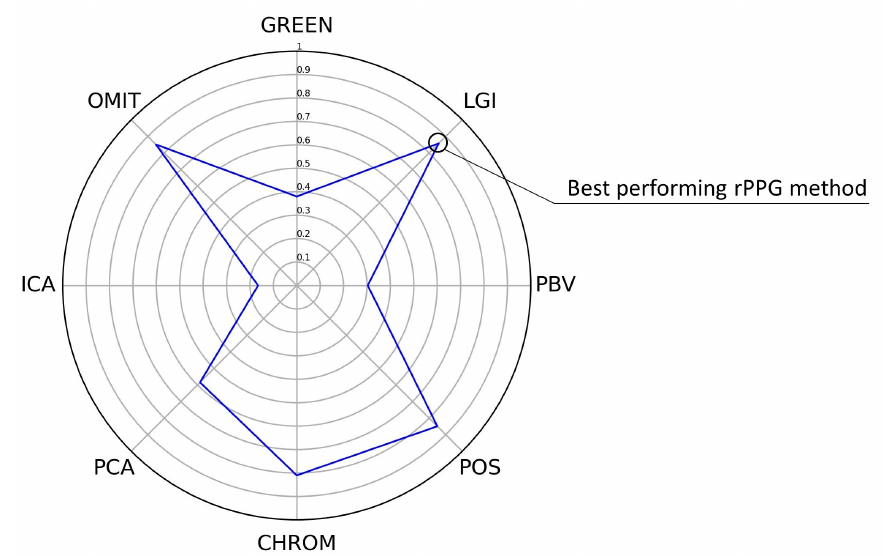
Figure 6. Average OS score for each rPPG method. Note that OS = overall evaluation